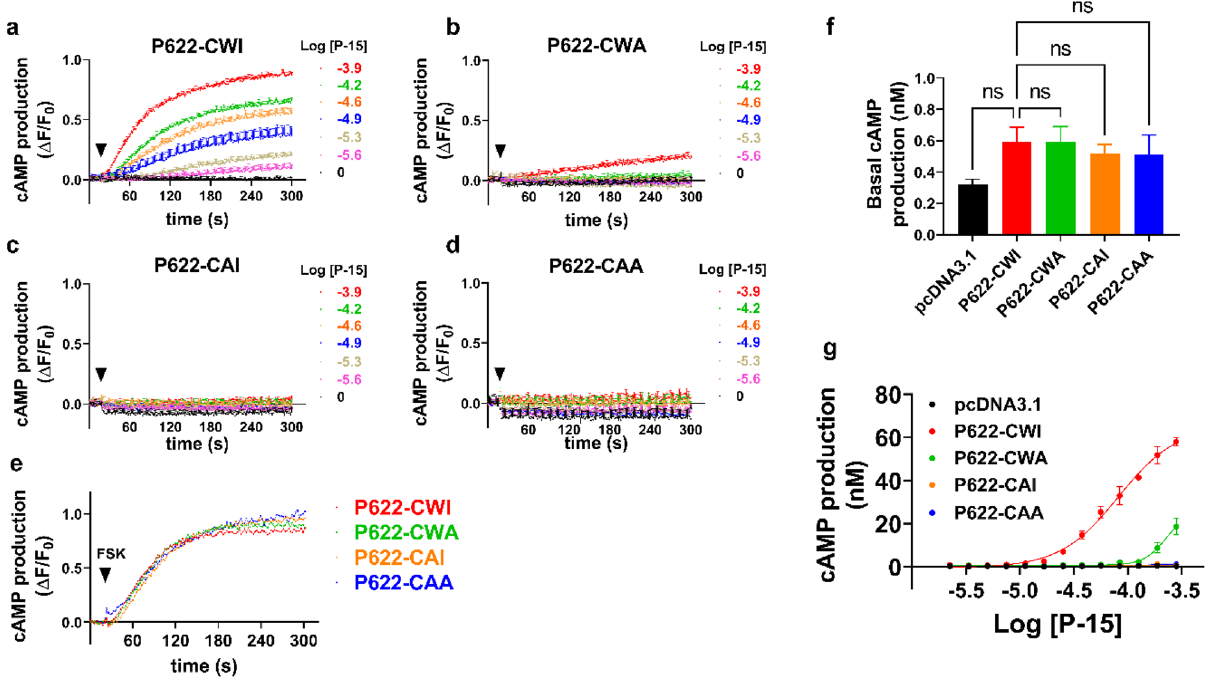
Figure 7. ECL2-mutated ADGRG2-P622 receptors are not activated by P-15. ( a – d ) Cells were transfected with adjusted doses of P622-CWI and mutant plasmids and were transduced with a cAMP biosensor overnight. After a 20-s basal recording of fluorescence (Ex: 488 nm; Em: 525 nm), cells were activated with increasing concentrations of P-15 (arrowheads), and fluorescence was recorded for another 280 s. Relative fluorescence unit (RFU) data were analyzed in GraphPad Prism and are presented as change in RFU divided by the initial RFU (ΔF/F0). ( e ) Cells transfected with adjusted doses of plasmids and biosensor were stimulated with 1 µM forskolin (FSK). Data are mean ± S.E.M and are representative of 3 independent experiments performed in triplicate. ( f ) Basal cAMP production was measured after overnight incubation with 0.5 mM IBMX in starvation media in an HTRF assay. cAMP production in nM is presented as mean ± S.E.M from a representative experiment out of 3 independent experiments performed in triplicate. Data were compared with P622-CWI with one-Way ANOVA with Dunnett’s test. ns: not significant. ( g ) Cells were stimulated with increasing concentrations of P-15 for 2 h and cAMP production in nM was measured in an HTRF assay. Data are mean ± S.E.M from a representative experiment from three independent experiments performed in